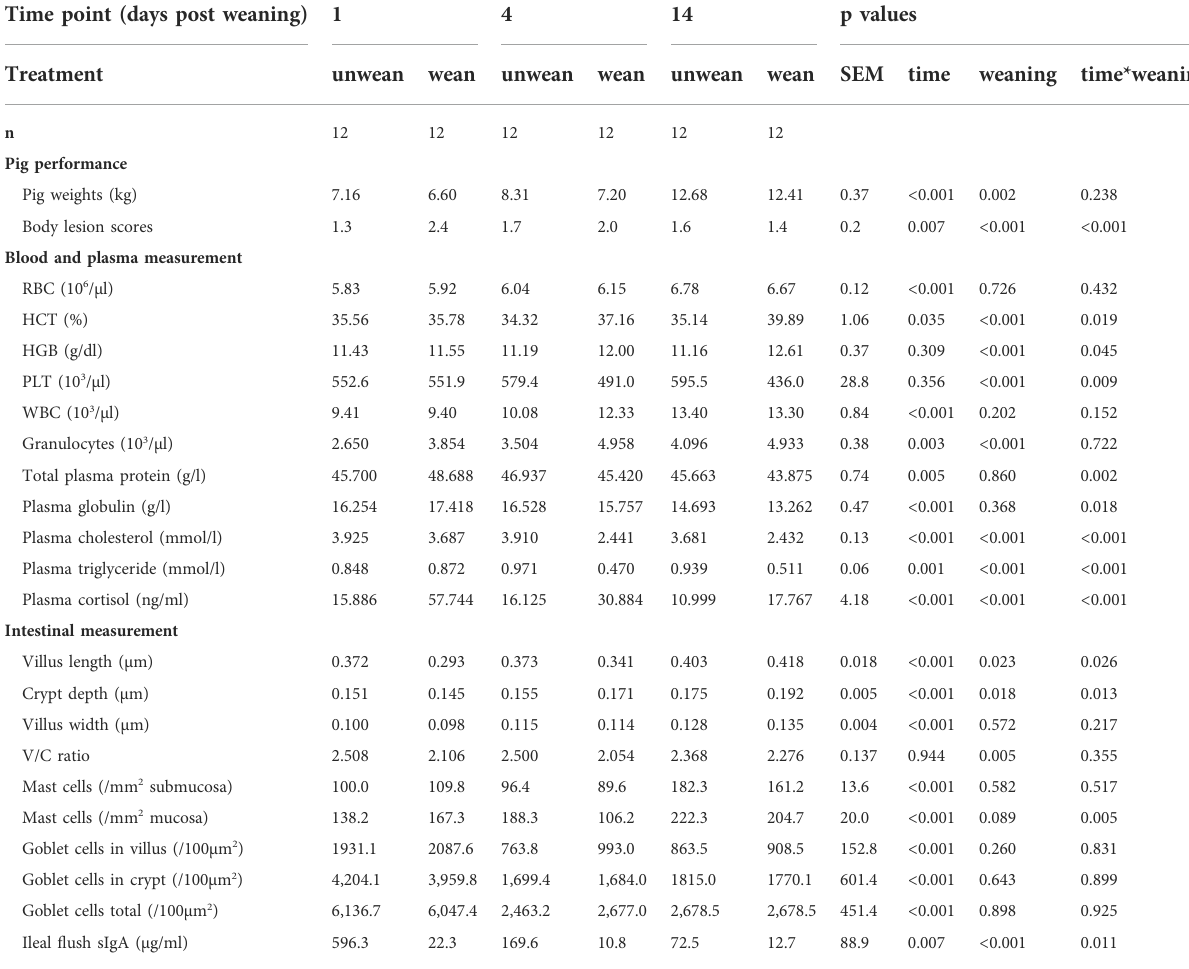
TABLE 1 Phenotypic measurements between weaned and unweaned pigs at 1, 4, and 14 days post weaning. Data shown are means and the pooled SEM for weaned and unweaned pigs for each time points. Time point (days post weaning)